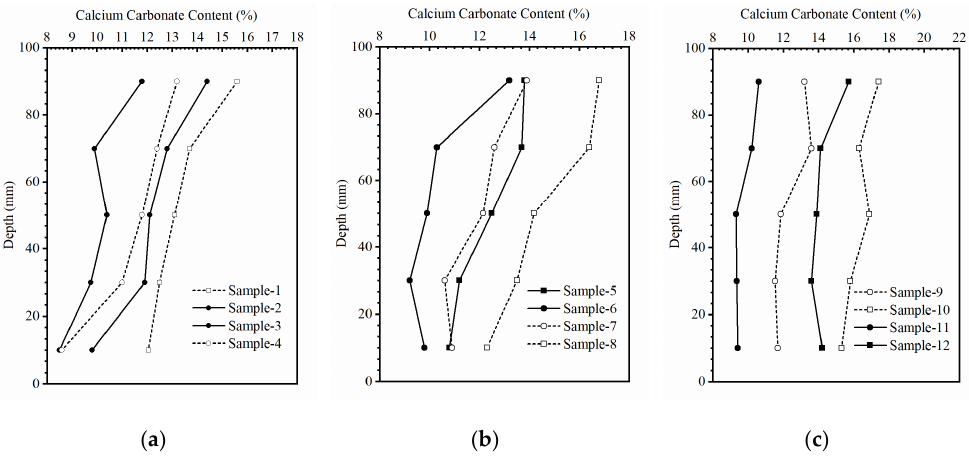
Figure 7. Quantification calcium carbonate contents along the height of solidified sand specimens: ( a ) 75–150 μm; ( b ) 150–300 μm; ( c ) 300–600 μm.